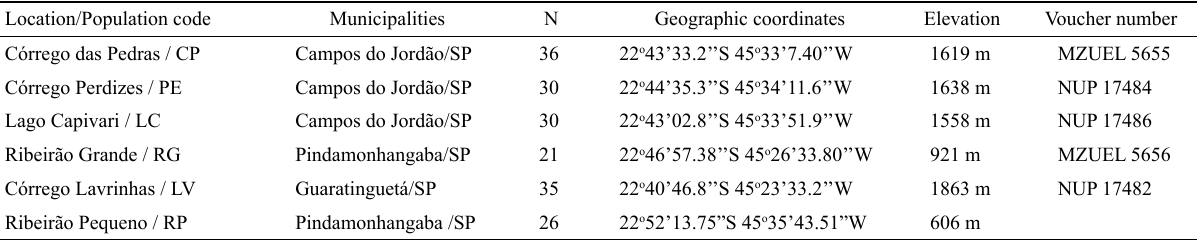
Córrego Lavrinhas /